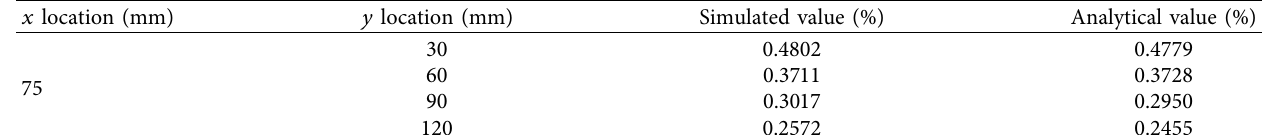
Table 2: Chloride concentration of 75mm depth ( t � 10